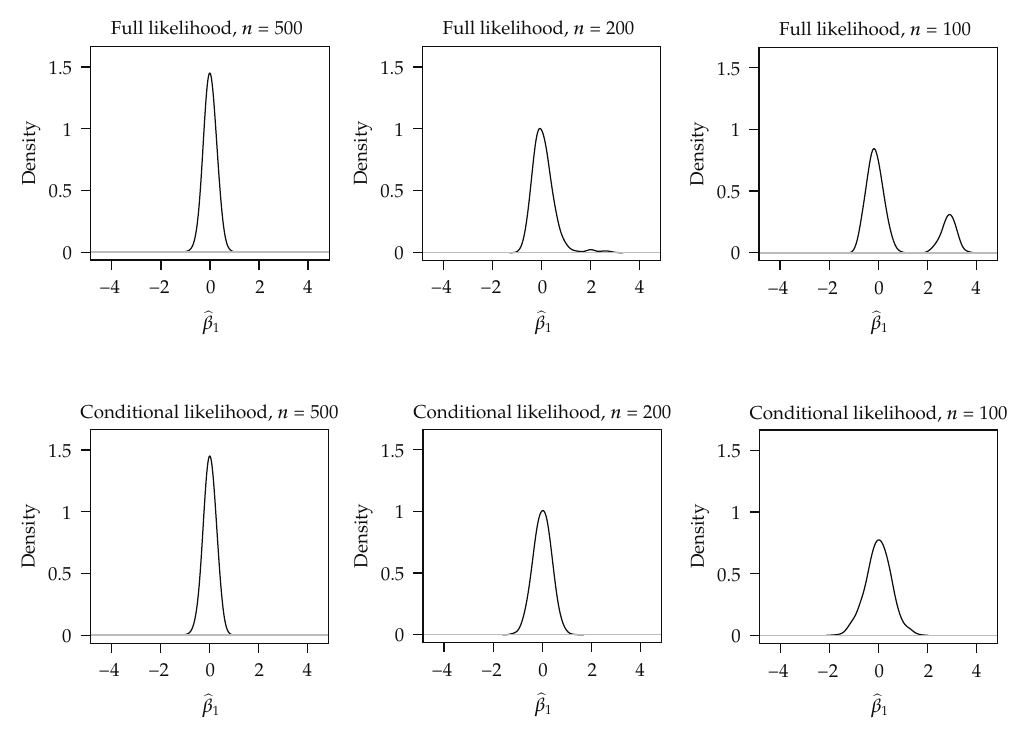
Figure 5: Sampling distributions for maximum likelihood estimates of regression coe ffi cient β 1 from 1000 replications; normal model fitted to NPQM data (cid:5) Y i ∼ NPQM (cid:5) 4 , 2 , 0 . 15 , 0 . 14 (cid:6)(cid:6)